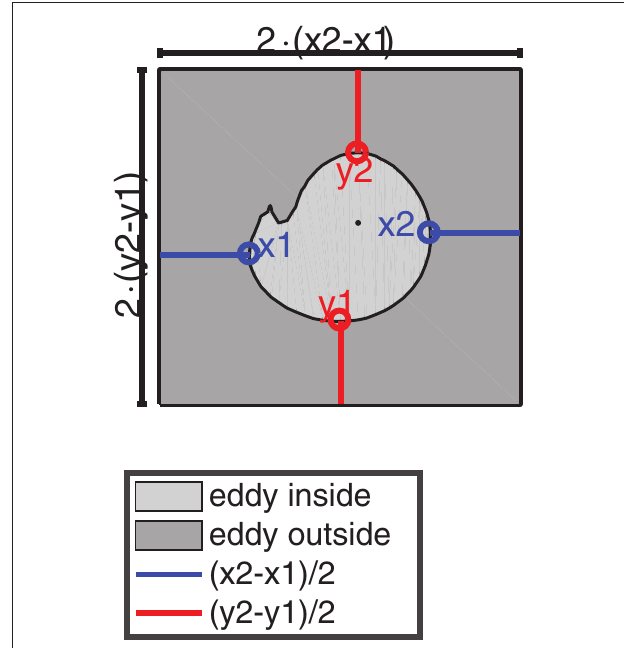
FIGURE 4 | Schematic sketch how the area inside and outside of an eddy is chosen. The light gray area indicates the region inside the eddy (here an eddy with a small filament). The dark gray box around the eddy is the area outside the eddy. The blue and red lines indicate the distance of the outer edges of the eddy boundary in x and y direction x1, x2, y1, and y2 to the box boundaries. The black dot indicates the eddy